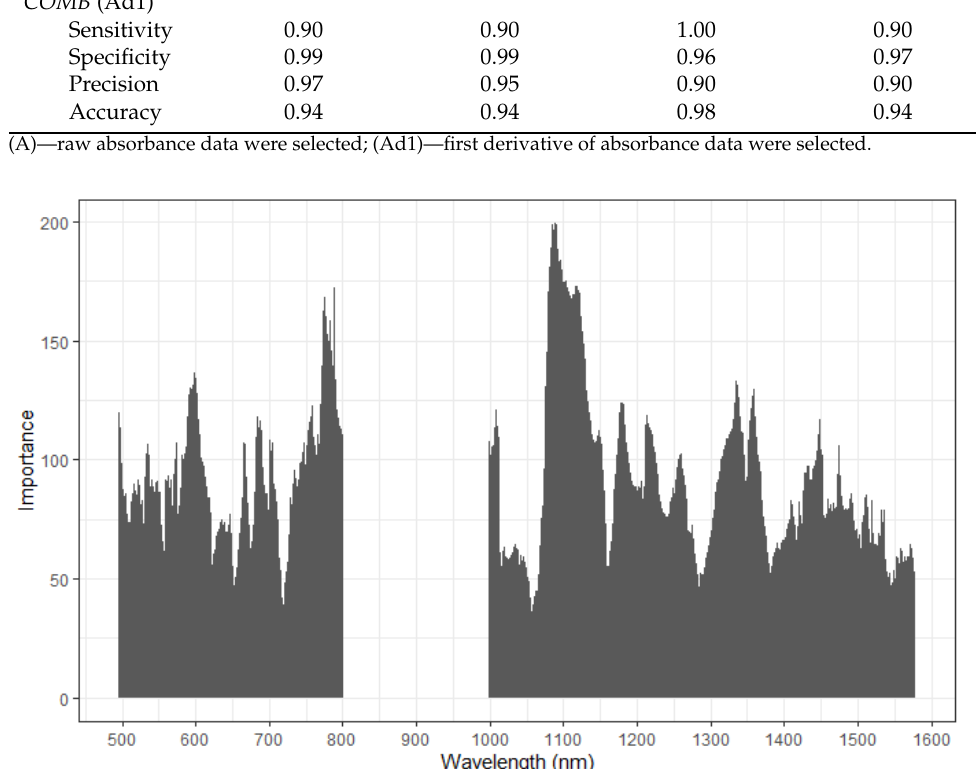
Table 5. Random forest algorithm classification accuracy and coefficient of agreement (Kappa, κ) from visible (VIS), short-wave infrared (SWIR) and combination VIS and SWIR (COMB) hyperspec- tral sensors to differentiate bovine and ovine hearts, kidneys, livers and lungs on the leave-one-out cross validation (LOOCV) and in-sample datasets.